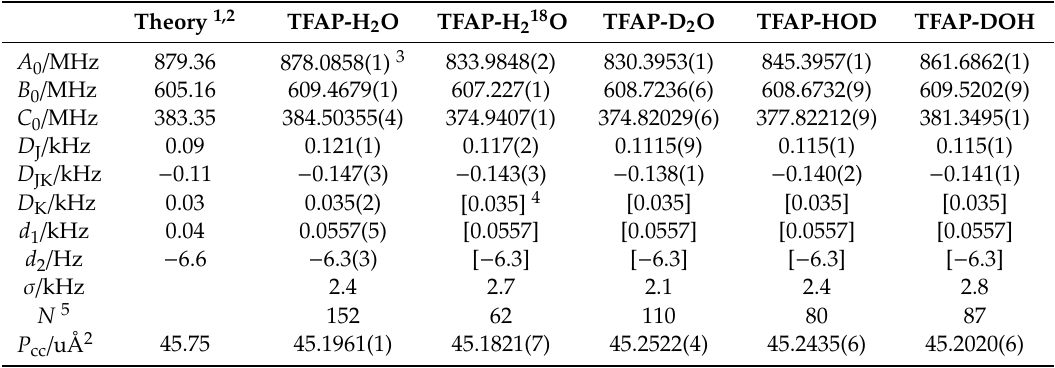
Table 2. Experimental spectroscopic parameters of di ff erent isotopic species of the TFAP-W isomer I ( S -reduction, III l